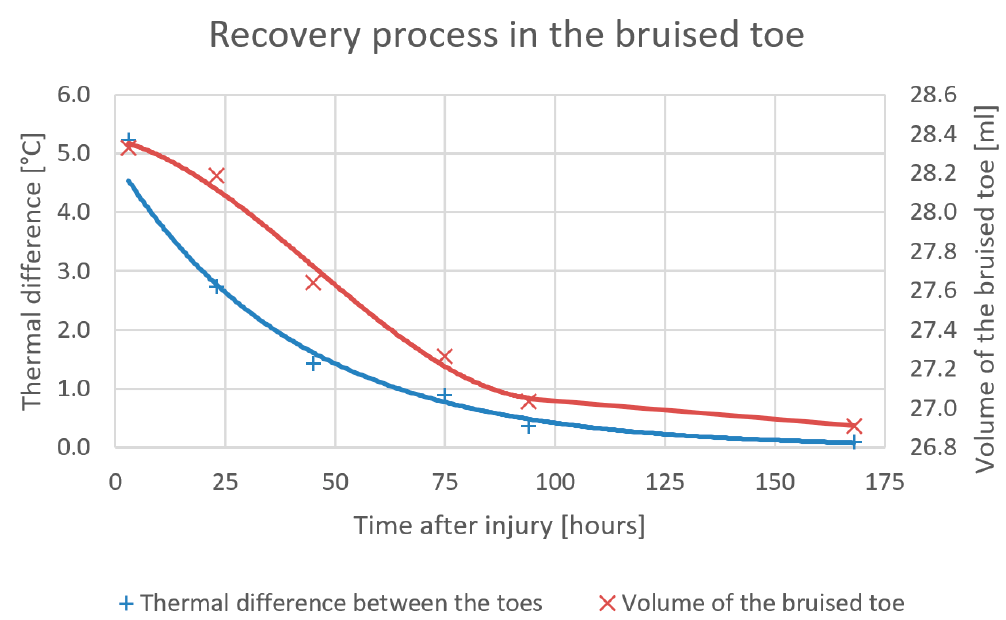
Figure 12. The progress curve relating to the average temperature in the region of the bruised toe, completed with an indication of the volume [35].